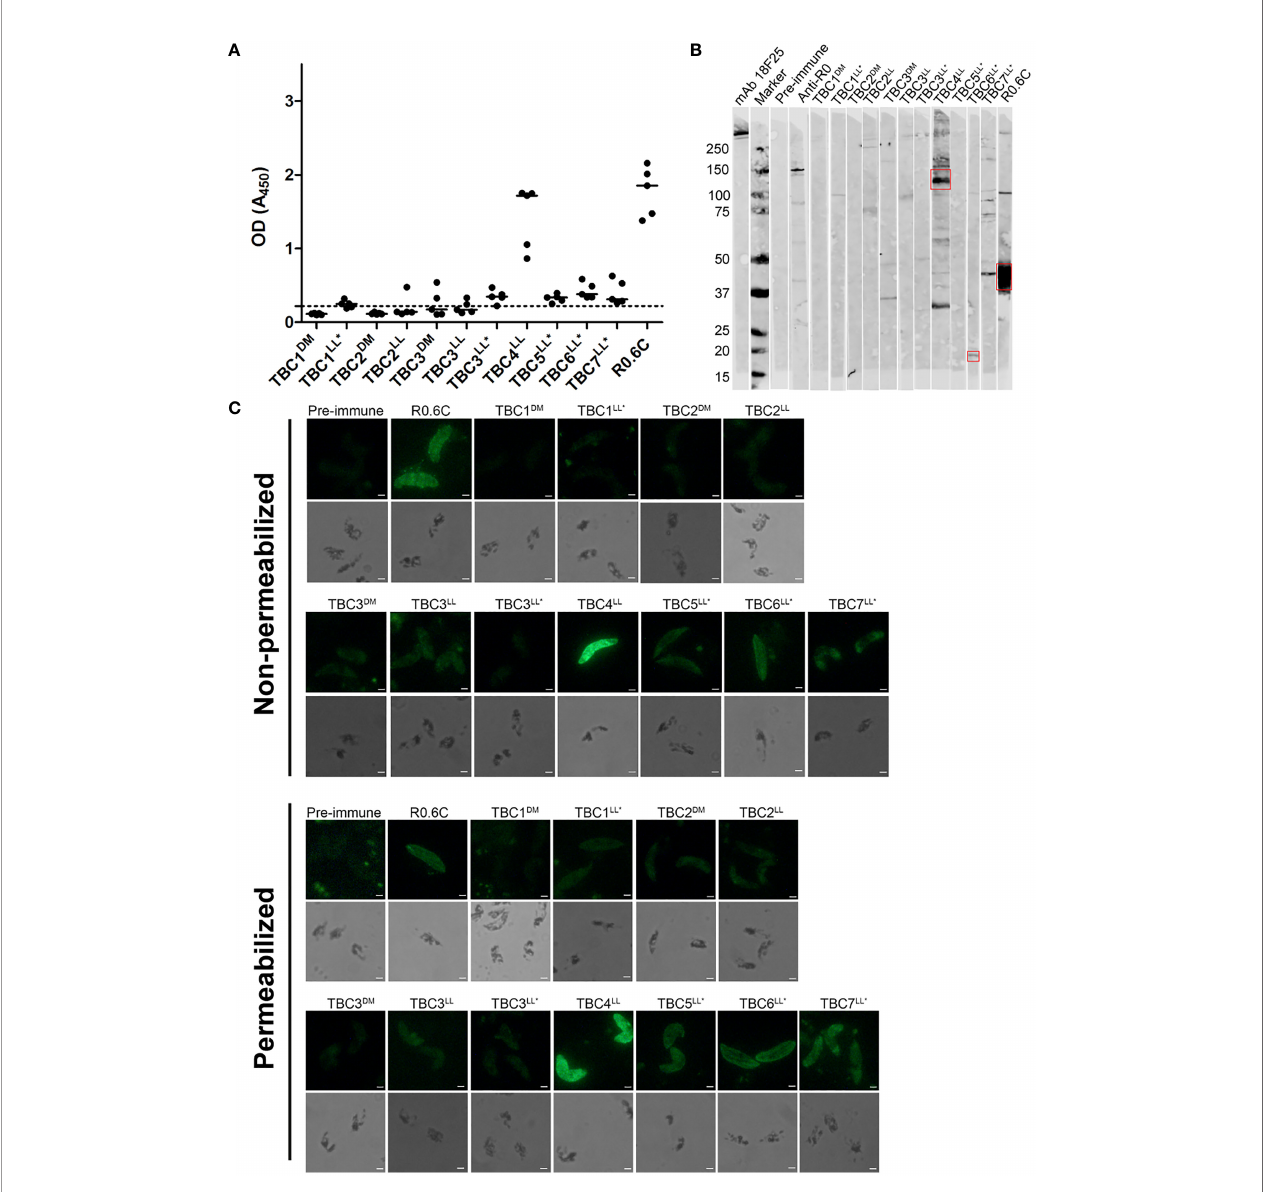
FIGURE 4 | Reactivity of antibodies with native gametocyte antigens. Antibody reactivity to antigens in gametocyte extracts was assessed by (A) ELISA and (B) western blot. (A) Raw optical density (OD) values are presented for each individual mouse antisera with the median against native gametocyte extract ELISA. The dotted line represents the mean of all pre-immune sera plus three times the standard deviation. Samples with OD values above this cut-off are considered positive. (B) The sera that showed recognition were repeated in another western blot with comparable results (Data not shown). Red boxes indicate the putative protein of interest. (C) Reactivity with whole gametocytes was analyzed by immuno fl uorescence assays. Fixed gametocytes were incubated with 1:100 dilution of sera under non-permeabilizing and permeabilizing conditions. Scale bar represents 10 µm. Names with * indicate antigens that were expressed as R0